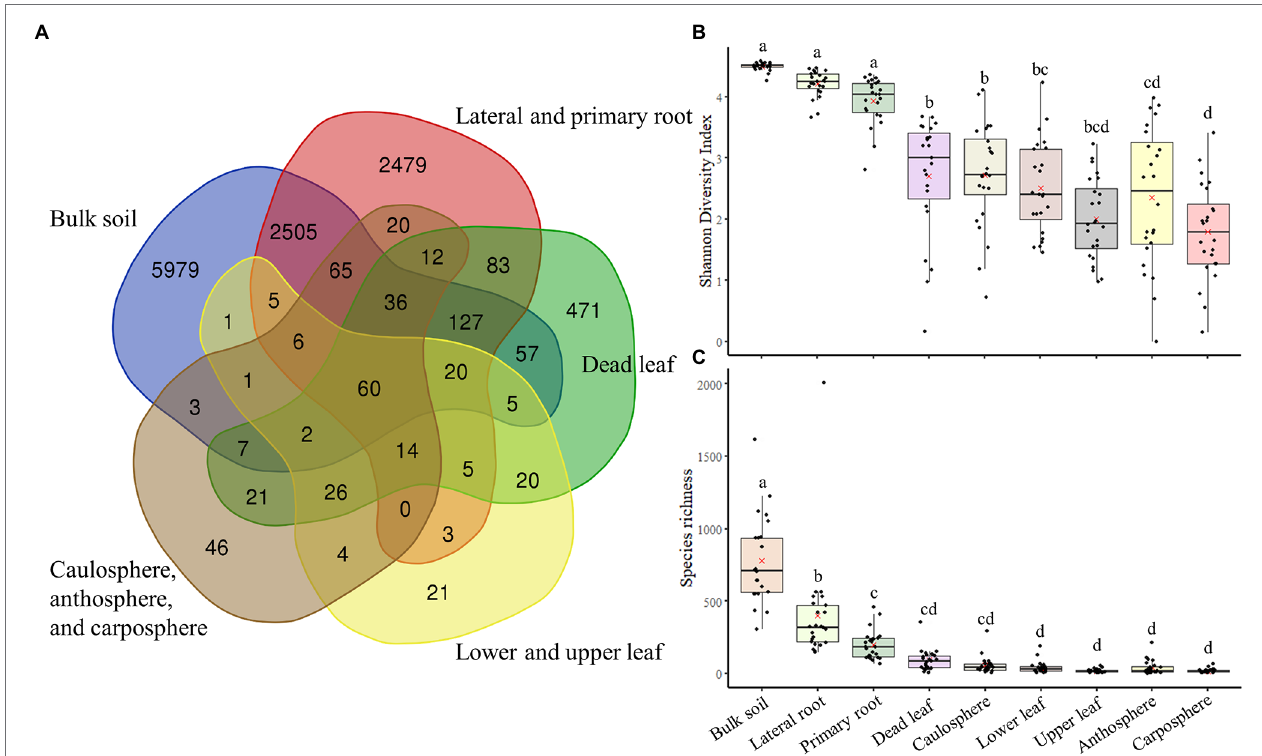
FIGURE 3 | Venn diagram of components, and diversity indices. (A) Venn diagram based on ASVs. (B) Shannon diversity index. (C) The Chao1 index. The letters on the top of the boxes indicates the results of the two-way ANOVA and Tukey-HSD test with the significance threshold of p >